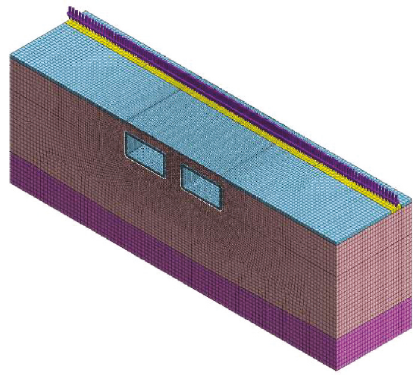
Figure 8: Schematic diagram of 3D finite element